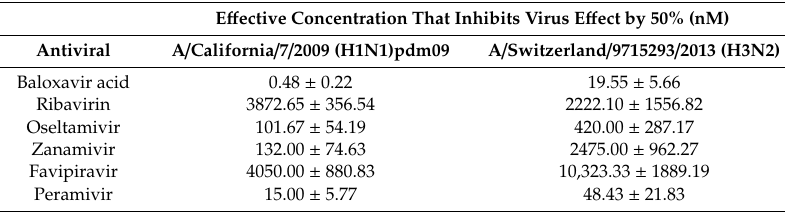
Table 1. Antiviral activity of individual drugs against two influenza A strains. E ff ective Concentration That Inhibits Virus E ff ect by 50% (nM)